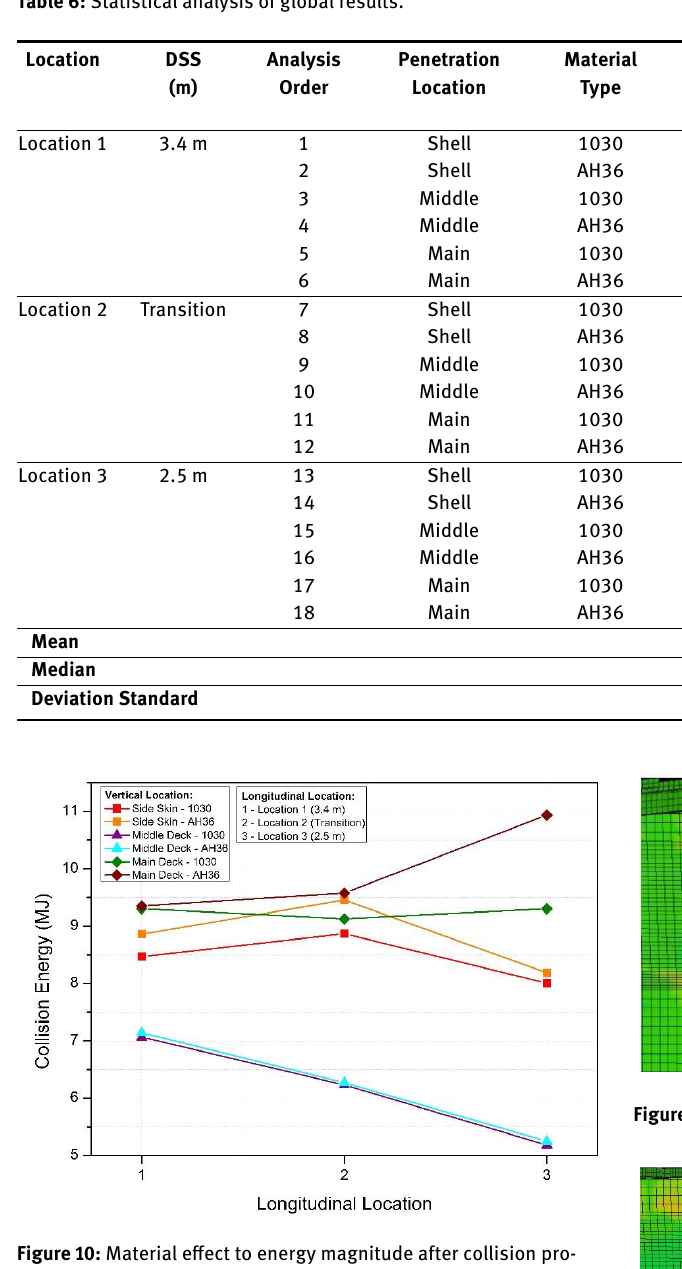
able damage, especially at wagon deck was